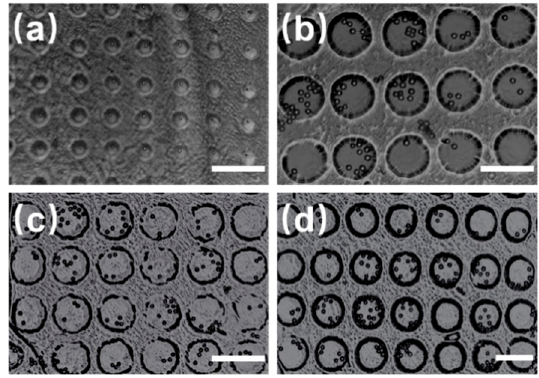
Figure 4. Microspheres captured in microwell arrays. The diameters are: ( a ) 30 μ m, ( b ) 50 μ m, ( c ) 70 μ m, and ( d ) 80 μ m. Scale bar: 100 μ m.